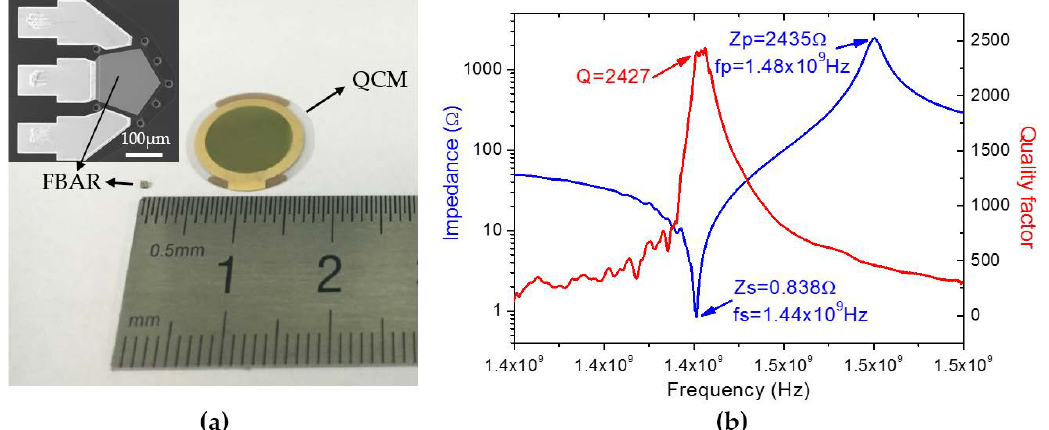
Figure 3. FBAR characterization. ( a ) A comparison of the size between FBAR and quartz crystal microbalance (QCM). The top-left inset shows the top-view scanning electron microscopy (SEM) image of FBAR; ( b ) magnitude of impedance and Q value over frequency.